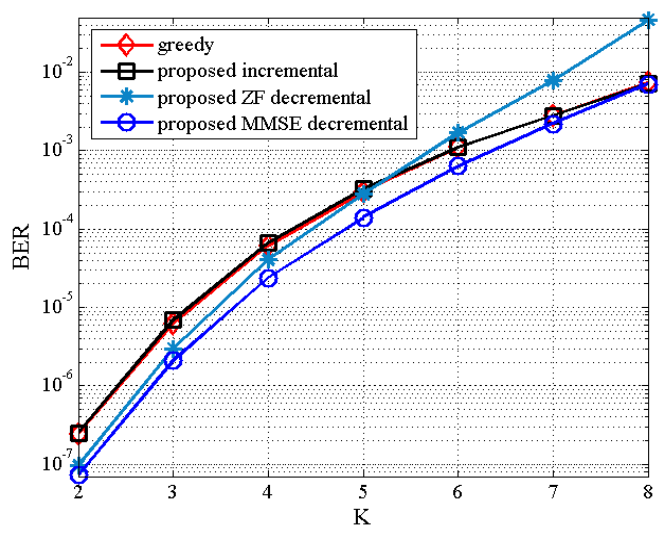
Figure 10. BER the proposed TAS selection algorithm for (8, , ) S N K MU–STLC system with N K under SNR = 16 dB. S